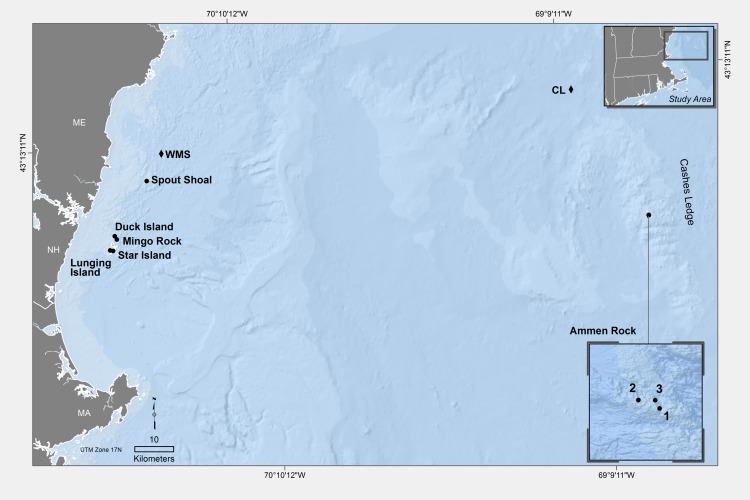
Map of the Gulf of Maine showing the location of the coastal and offshore (Cashes Ledge) sites.Cashes Ledge is located 145 km east of the New Hampshire coast with Ammen Rock at the center of the 29 km-long ridge. The site names are abbreviated as: AR1, AR2, AR3 designating Ammen Rock Sites 1–3 on Cashes Ledge and the coastal sites as: Spout Shoal (SS), Duck Island (DI), Mingo Rock (MR), Star Island (SI) and Lunging Island (LI). Sea Surface Temperature (SST) and wave height data were obtained from oceanographic buoy stations indicated by a diamond symbol with CL for the Cashes Ledge Buoy and WMS for the Western Maine Shelf Buoy. The scale bar is 10 km. Specific GPS coordinates for centrally located sites in the coastal and offshore region are: DI 43 00. 667 N x 70 60. 517 W, and AR1 42 53.4348 N x 068 56.6106 W. This map was produced by L. Carlson using Esri software licensed to Brown University.